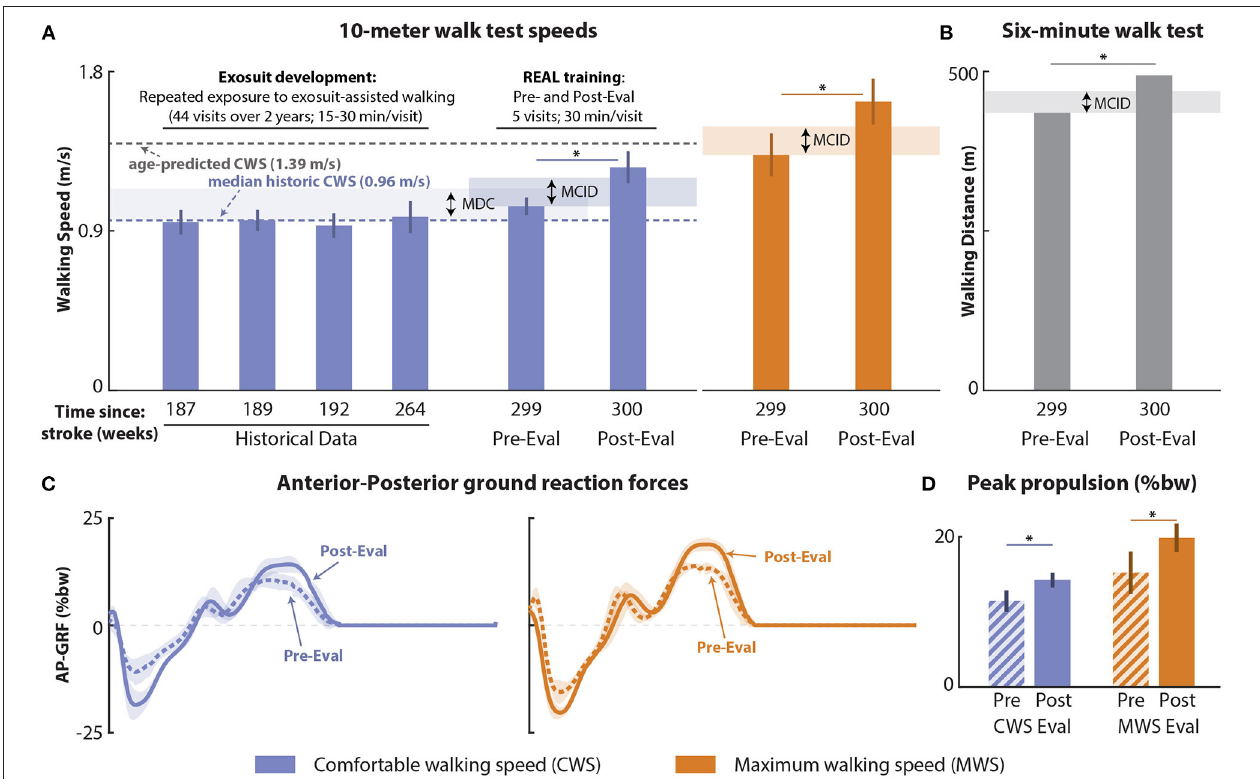
FIGURE 3 | Effects of Robotic Exosuit Augmented Locomotion (REAL) training on 10-m walk test speeds and 6-minute walk test distance. (A) Five comfortable walking speed measurements repeatedly assessed over 2 years prior to the onset of REAL training (four historical timepoints and one pre-training evaluation conducted immediately before the training period), post-training evaluation comfortable walking speed, and pre-to-post maximum walking speeds. (B) Pre-to-post comparisons of 6-minute walk test distance. (C) Time series of anteroposterior ground reaction forces (AP-GRF) of each speed condition; (D) Peak propulsion of